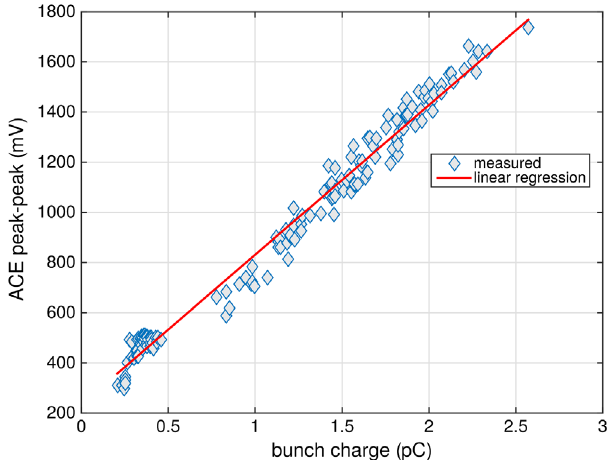
FIG. 9. Scatter plot of ACE field-strength measurements vs beam currents established from a commercial integrating current transformer (ICT), showing that the signal response is linearly proportional to beam bunch charge.